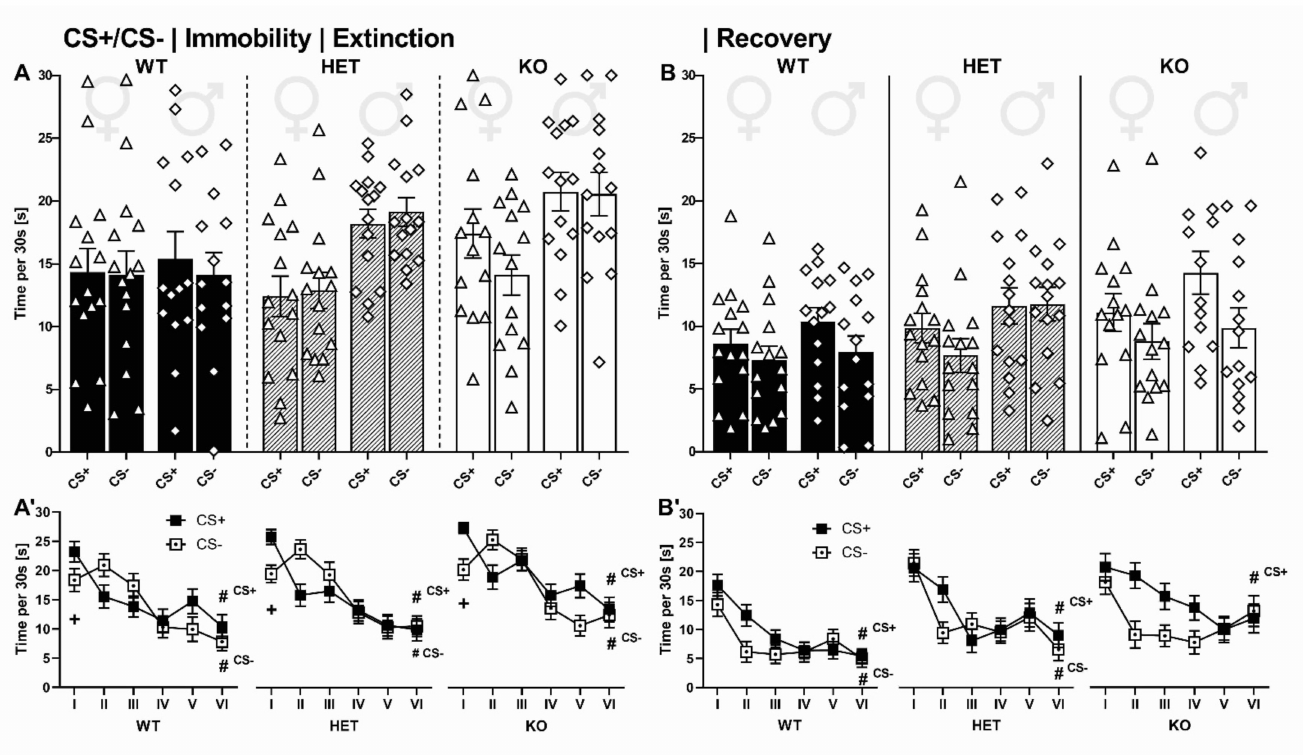
Figure 6. CS+/CS- presentation: Immobility, grouped by genotype and sex. Effects of SERT deficiency on immobility per 30 s time bin for CS+ and CS- presentation during extinction ( A , A’ ) and recovery ( B , B’ ). Depicted are the total amounts of immobility for both CS+ and CS- presentations for SERT +/+ (black bar), SERT +/ − (striped bar), and SERT − / − (white bar) rats. Two bars on the left comprise CS+ and CS- presentations for females; males are shown on the two right bars of every genotype. Furthermore, single trial immobility levels for extinction ( A’ ) and recovery ( B’ ) are shown by means of CS+ presentations (black squares) and CS- presentations (white squares with dot). N = 29 SERT +/+ (15 female, 14 male), 30 SERT +/ − (15 female, 15 male), 28 SERT − / − (14 female, 14 male) rats. Data are presented as mean ± SEM. TRIAL* p < 0.05 effect of time course. # p < 0.05 significant within-subject comparison of various CS presentations. + p < 0.05 for within- subject comparison of first CS+ and CS- presentation. #CS+ p < 0.05 for within-subject comparison of first and last CS+ presentation. #CS- p < 0.05 for within-subject comparison of first and last CS-